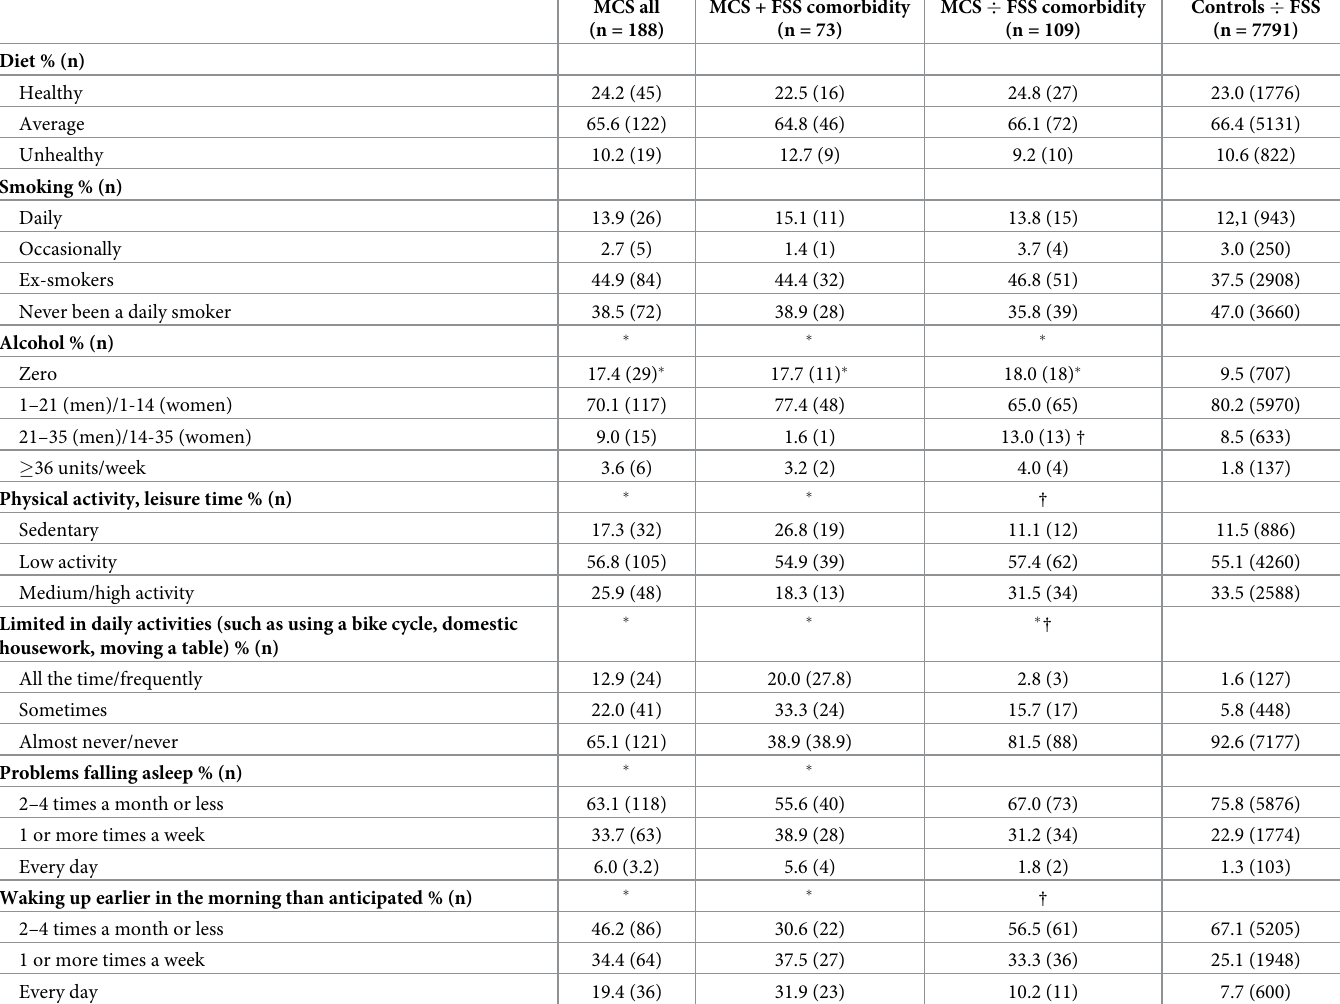
Table 3. Selected lifestyle factors of participants meeting criteria for multiple chemical sensitivity (MCS) and of controls not meeting the criteria for any of five functional somatic syndromes